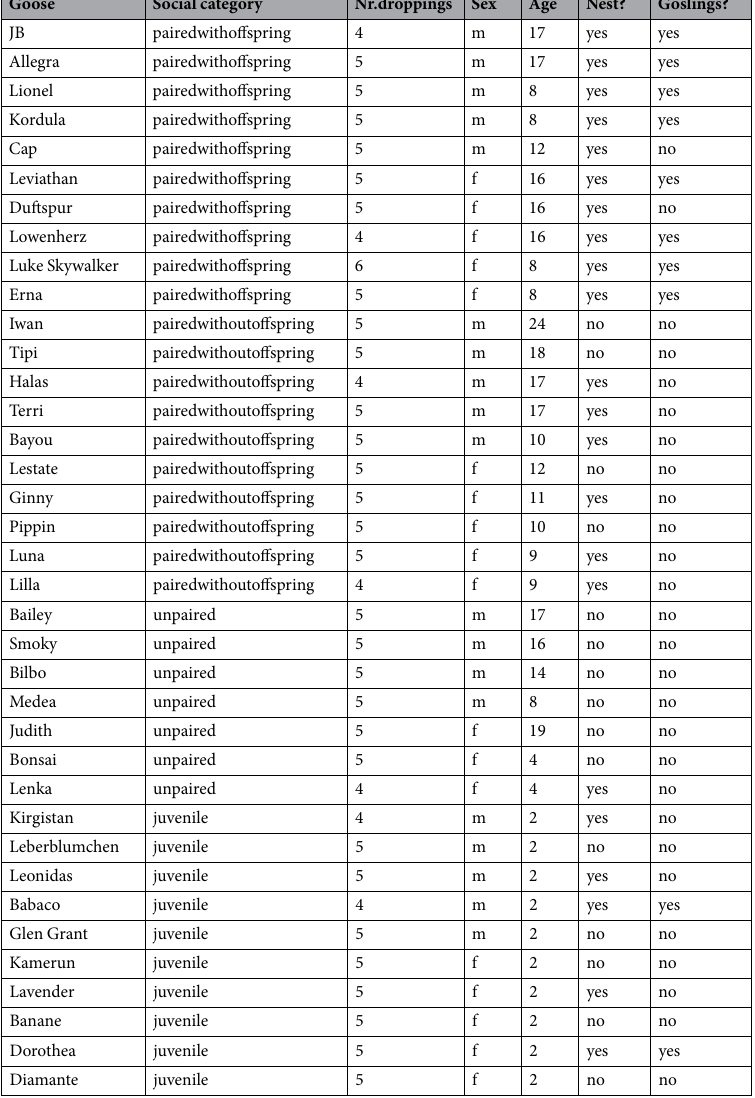
Table 3. List of the focal individuals, their social status at the time of data collection, their age (years), sex (m = male, f = female) and information about their reproductive